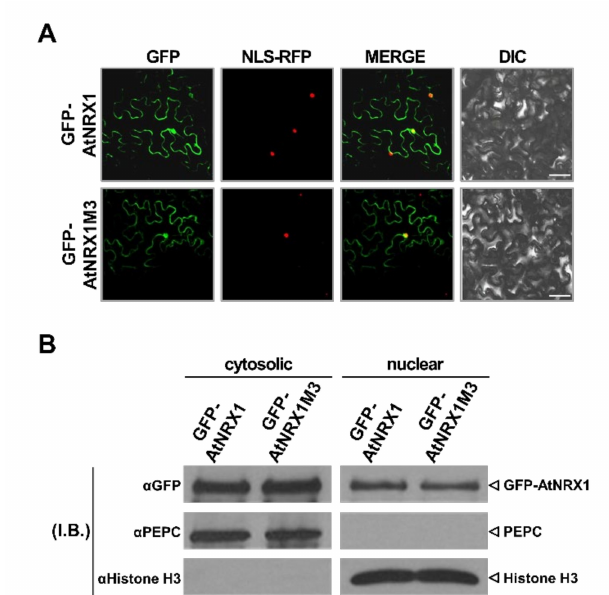
Figure 3. Subcellular localization analysis of AtNRX1 and AtNRX1M3. ( A ) Subcellular localization patterns of GFP-AtNRX1 and GFP-AtNRX1M3 in agroinfiltrated tobacco leaves. Tobacco leaves were co-infiltrated with NLS-RFP and GFP-AtNRX1 or GFP-AtNRX1M3 . The fluorescence signals of GFP (left panel) and RFP (second panel) were observed by confocal microscopy of epidermal cells at 3 days post-infiltration (dpi). To confirm the nuclear localization of GFP-AtNRX1 and GST-AtNRX1M3, GFP and RFP images were merged (third panel). Di ff erential interference contrast (DIC) images (right panel) of the fields are shown. Scale bars = 100 µ m. ( B ) Fractionation analysis of GFP-AtNRX1 and GFP-AtNRX1M3 produced in agroinfiltrated tobacco leaves. The GFP-AtNRX1 and GFP-AtNRX1M3 constructs were infiltrated into tobacco leaves. Total proteins were extracted from leaves, and the cytosolic and nuclear fractions were separated. The protein level of GFP-AtNRX1 was determined by immunoblotting (I.B.) with anti-GFP antibody. The degree of fraction enrichment was determined using antibodies specific to marker proteins (anti-histone H3, nuclear marker; anti-PEPC, cytosolic marker). Experiments were repeated three times with similar